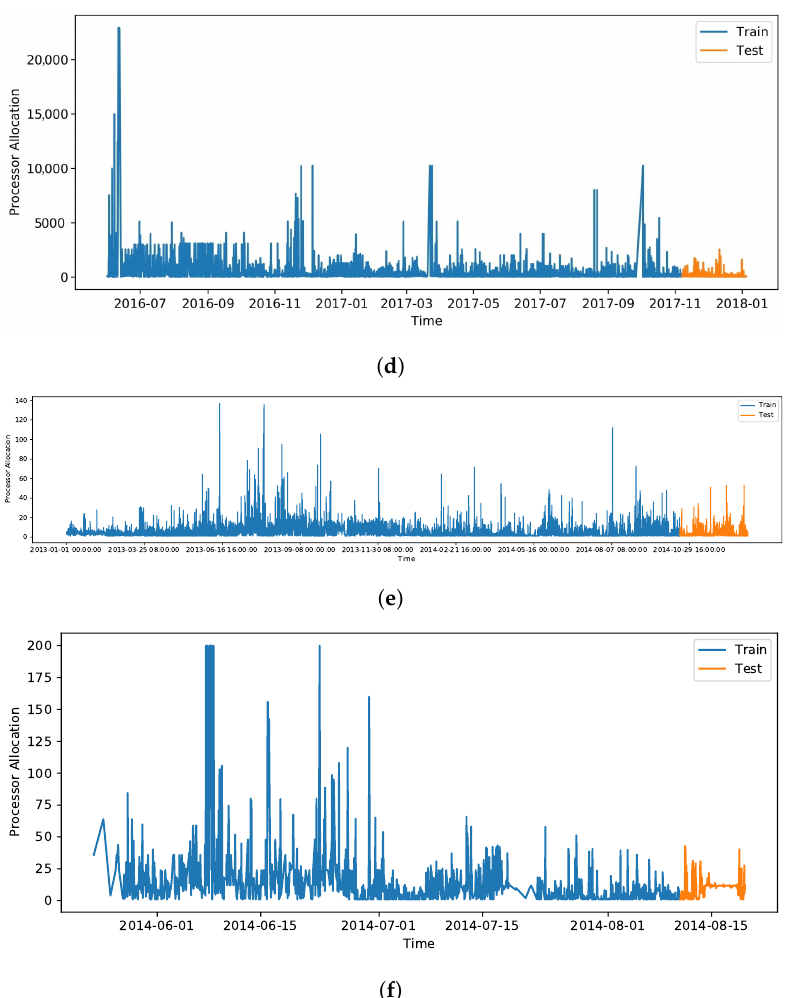
Figure 7. Train/Test split of datasets representing processor allocation and data collection